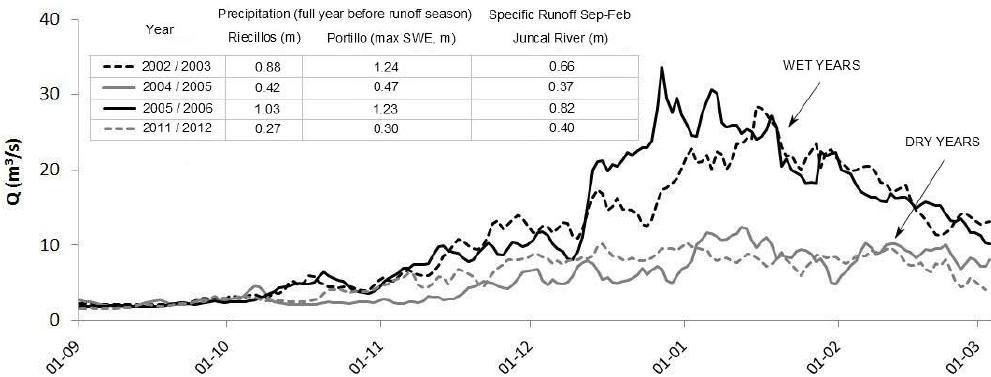
Fig. 5. Juncal discharge in two wet and two dry years. The inserted table shows precipitation data and cumulative discharge for the same example years. Table 2. Average δ 2 H and δ 18 O in all sample types with standard